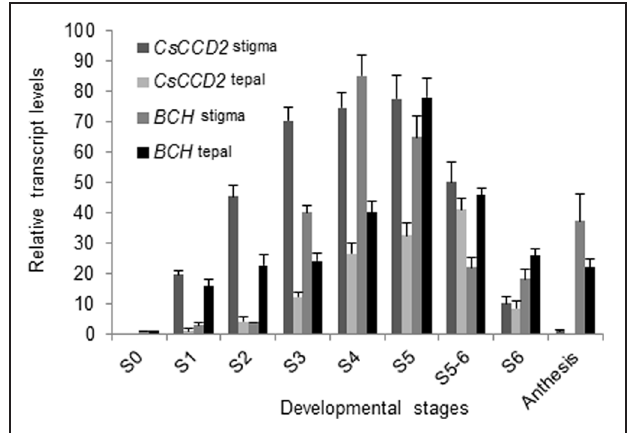
FIGURE 5 | CaCCD2 transcript accumulation (normalized to the household gene RSP18 ) in the flowers tissues of C. ancyrensis along their development. Values are means of three technical replicates ± SE, normalized to the internal control gene. The relative expression levels of BCH were incorporated for